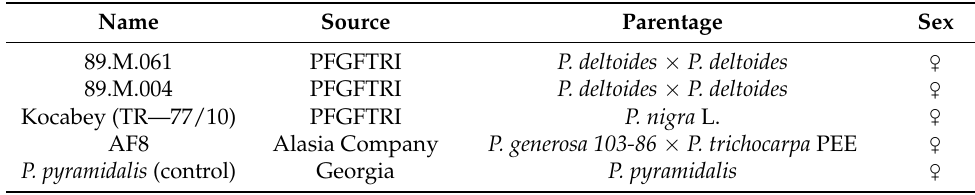
Table 2. Poplar clones used in the experiment in eastern